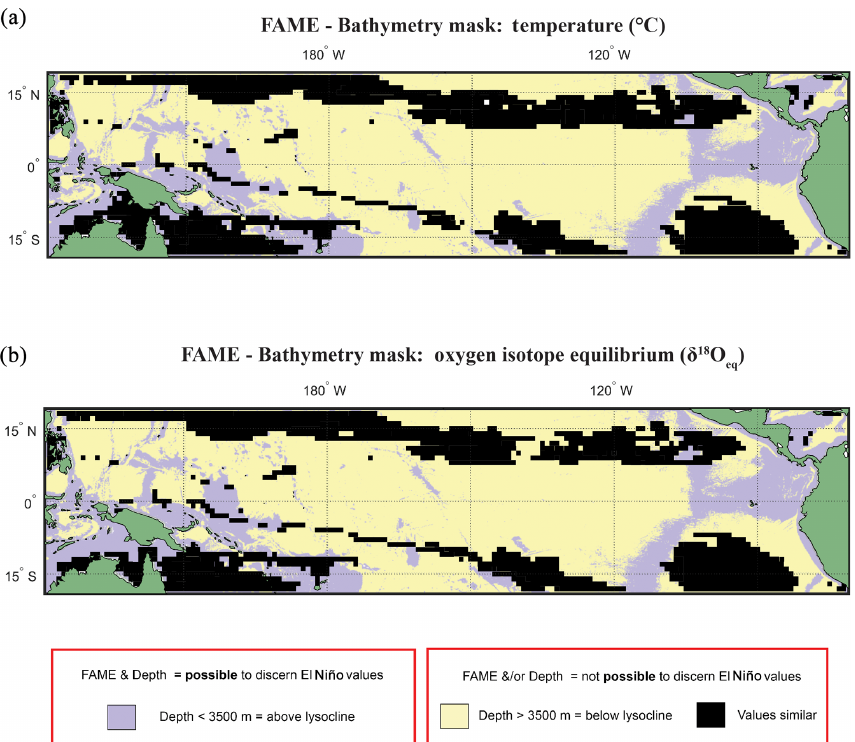
Figure 6. Overlay between bathymetry and FAME results. The results of the FAME Anderson–Darling test for (a) temperature and (b) oxy- gen isotope values as input. Locations where the H 1 hypothesis can be accepted, i.e. where the distributions can be said to be different (FP ElNiño (cid:54)= FP Non-ElNiño ), are plotted as yellow where the depth is deeper than 3500mb.s.l. or purple where the depth is shallower than 3500mb.s.l. (see Fig. 2). Purple locations are where our results suggest that the signal of ENSO has different values and the water depth allows for